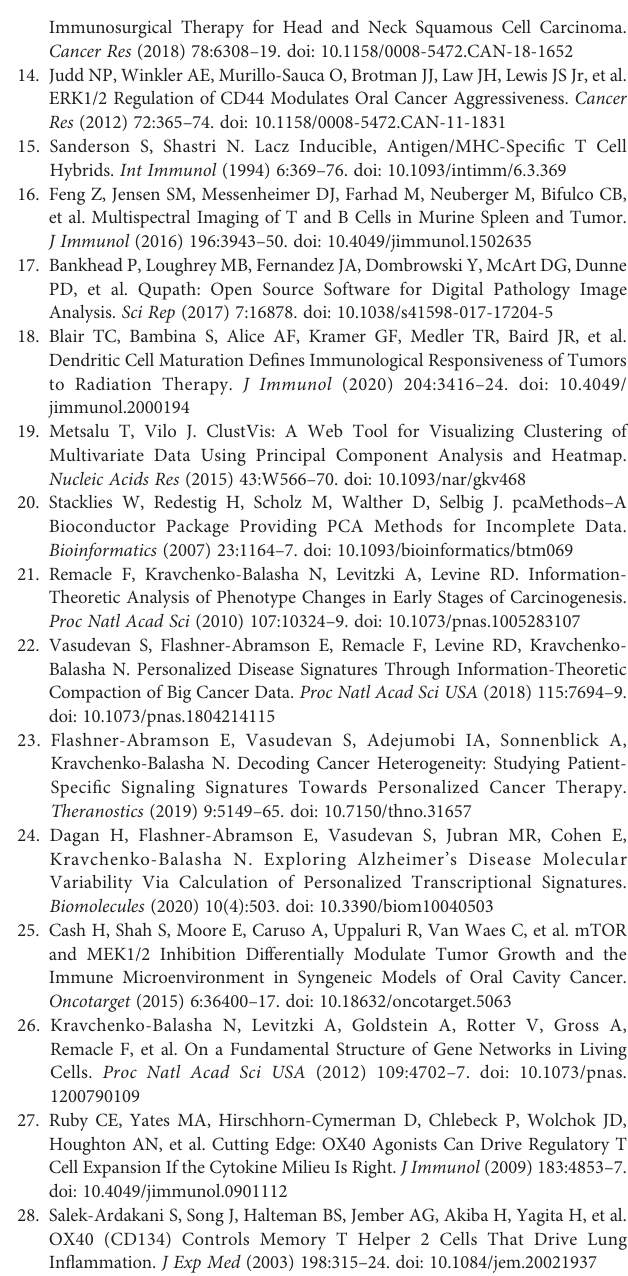
Supplementary Figure 1 | Flow cytometry of tumor explants. (A) Treated and control explants were harvested after 24 hours and individually digested for fl ow cytometry. Flow cytometry gating to identify CD90+ lymphocytes, CD4+ and CD8+ T cells, and CD4+CD25+ cells. (B) Quanti fi cation of in fi ltrating cells in each